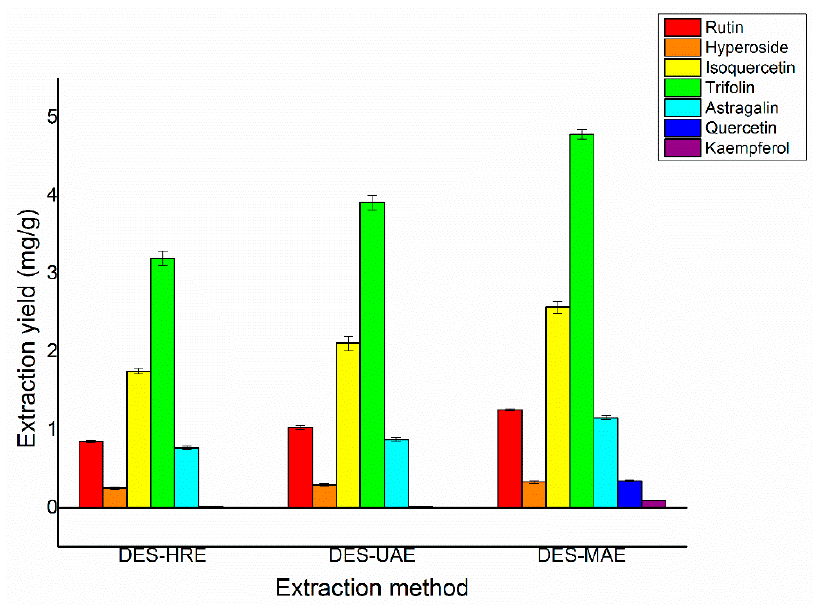
Figure 6. Comparison of different extraction methods on the extraction yields of rutin, hyperoside, isoquercetin, trifolin, astragalin, quercetin, and kaempferol.